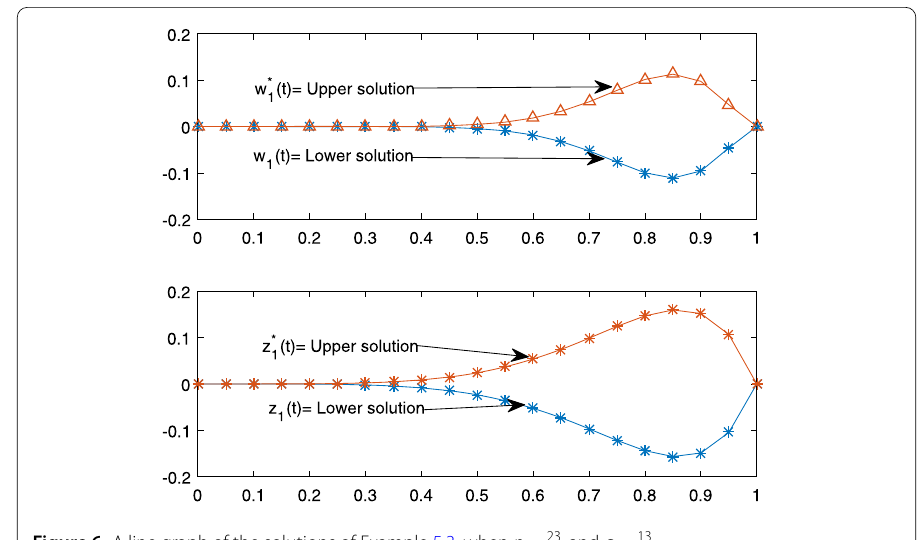
Figure 6 A line graph of the solutions of Example 5.3, when p = 23